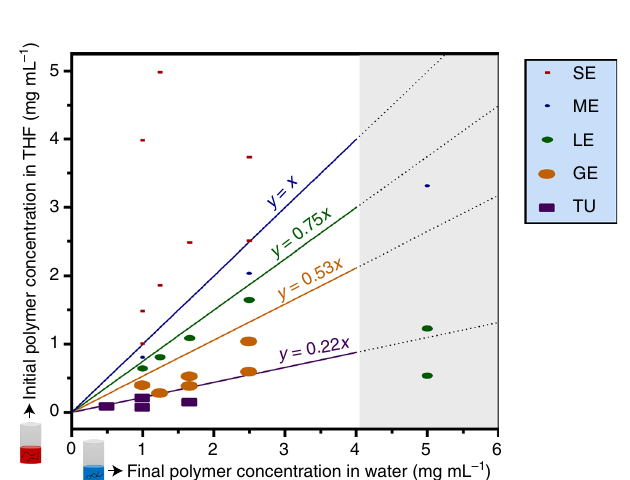
Fig. 3 Phase diagram for the self-assembly of PEG 43 - b -P(NIPAM 21 - co - PDMI 9 ) using different THF:water solvent systems. GE, giant ellipsoidal polymersomes; ME, medium ellipsoidal polymersomes; SE, small ellipsoidal micelles; TU, tubular polymersomes. Phase boundaries are represented by straight lines of equation y = mx + c (where m = 1, 0.75, 0.53, or 0.22) as depicted in the diagram. The phase boundary lines can be interpreted as follows: in order to obtain ME, one can use any solvent combination that lies within the region between y = 0.75 x (green straight line) and y = x (blue straight line); e.g., if a fi nal polymer concentration in water of 1 mg mL − 1 is used, the initial polymer concentration in THF should be between 0.75 – 1 mg mL − 1 . The gray highlighted region on the right side of the phase diagram indicates a region in which the phase boundary lines become no longer valid due to the tendency of the polymer to precipitate